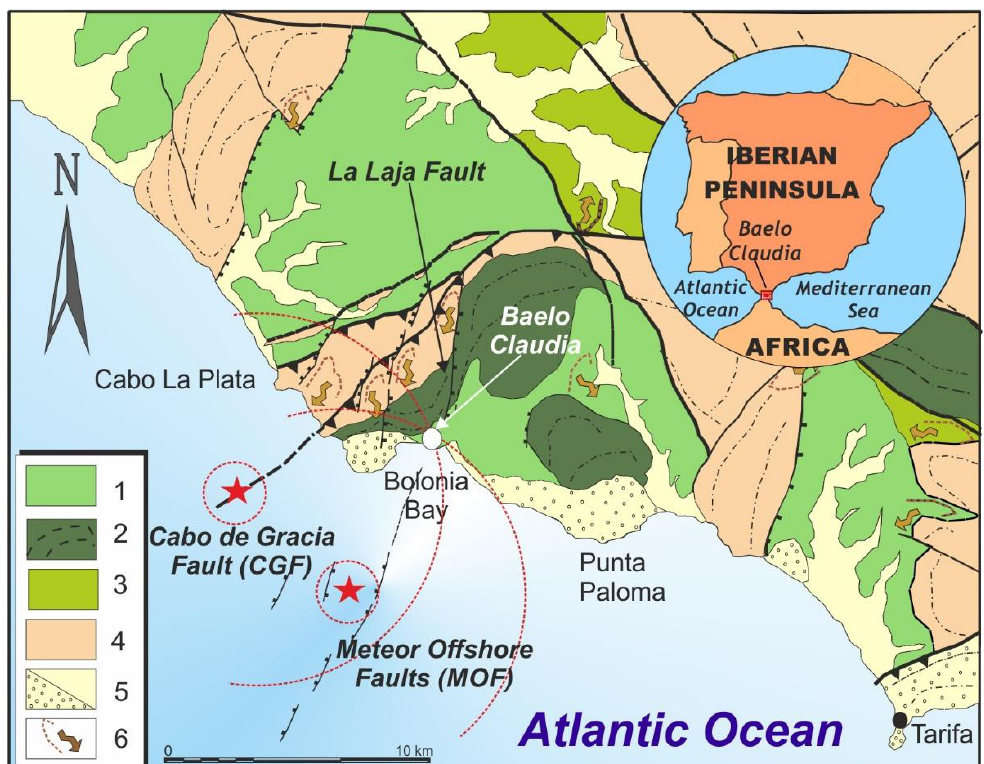
Figure 1. Geological context of the Bolonia Bay showing the most important fault systems in the central area of the Strait of Gibraltar and the most probable seismic sources (CGF and MOF) in the area responsible for the earthquake in the fourth century AD (red stars). Legend: (1) Cretaceous–Eocene Almarchal Fm. (clayey marls and limestones); (2) Paleogene Bolonia Fm. (red clays and limestones); (3) Lower Miocene Facinas Fm. (clayey olisthostromic unit); (4) Miocene Aljibe Sandstones and Algeciras Fms. (flysch units); (5) Pliocene (with circles) and Quaternary post-orogenic materials; (6) Major landslides identified in the area. Stratification directions and subvertical folds are identified with dashed lines. Normal faults (with squares) and reverse faults (with triangles) are identified using conventional symbology. Modified from Silva et al. [14].